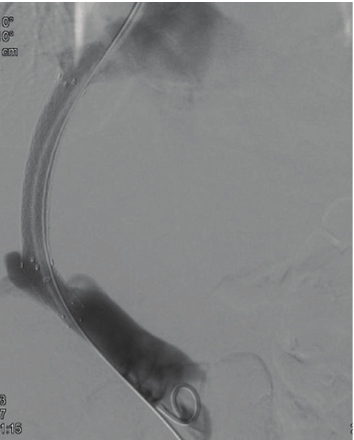
Figure 3: TIPS made with PTFE-covered stents between portal and right hepatic